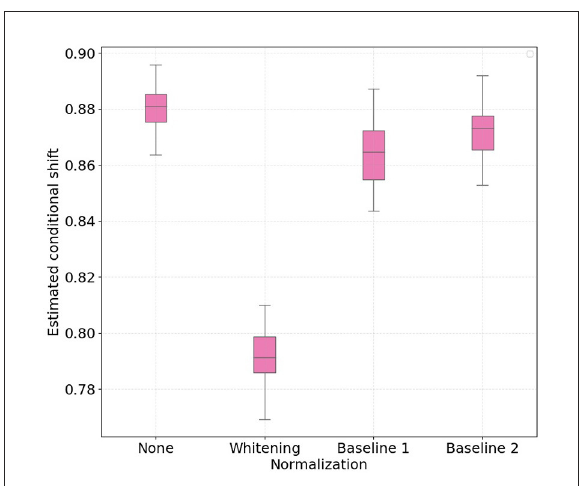
FIGURE2 Boxplots with 30 independent estimates of the aggregate cross-subject conditional shift across different normalization strategies for participants which performed physical activity using a bike . Lower values represent smaller estimated conditional